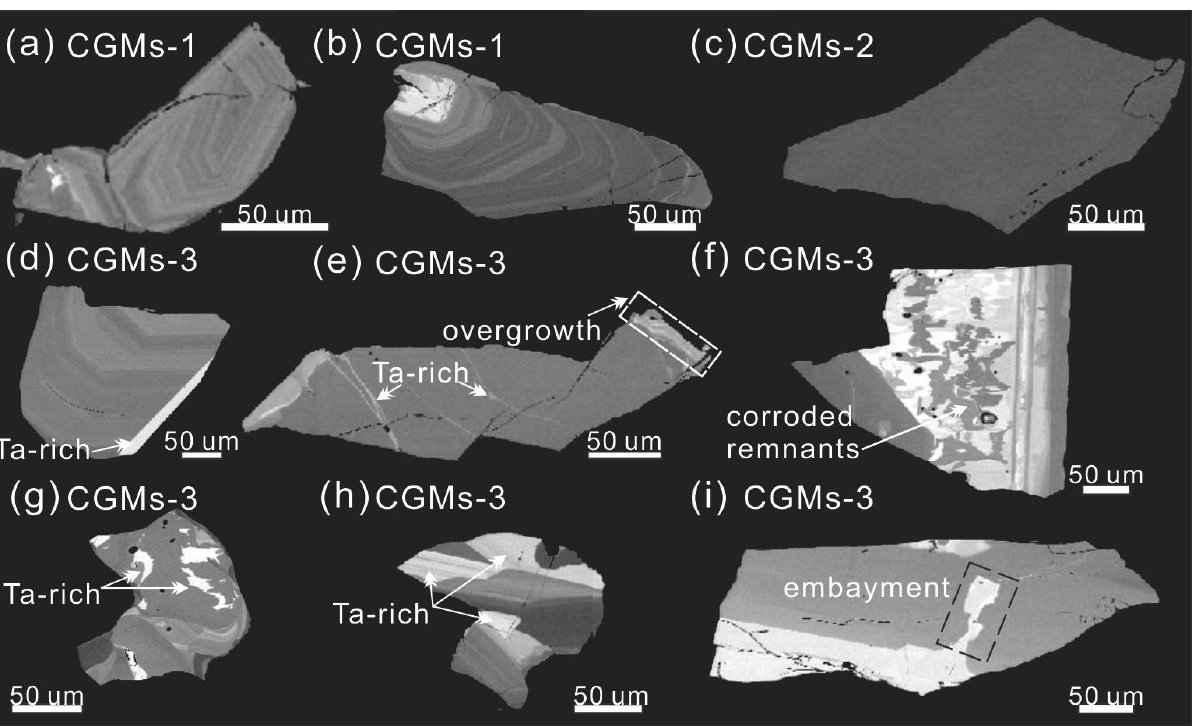
Figure 4. Back-scattered electron images of the CGMs. ( a , b ): oscillatory CGMs-1 grains; ( c ): homogenous CGMs-2 crystal; ( d ): Ta-rich patch overgrowth on CGMs-1; ( e ): Ta-rich domains crosscutting Nb-rich domain; ( f ): corroded Nb-rich fragments remained in the Ta-rich domain (metasomatic relict texture); ( g ): small worm-like Ta-rich domains occurred into the Nb-rich do- main (metasomatic myrmekitic texture); ( h ): CGMs-3 with mottled zoning; ( i ): CGMs-3 with em- bayment texture.